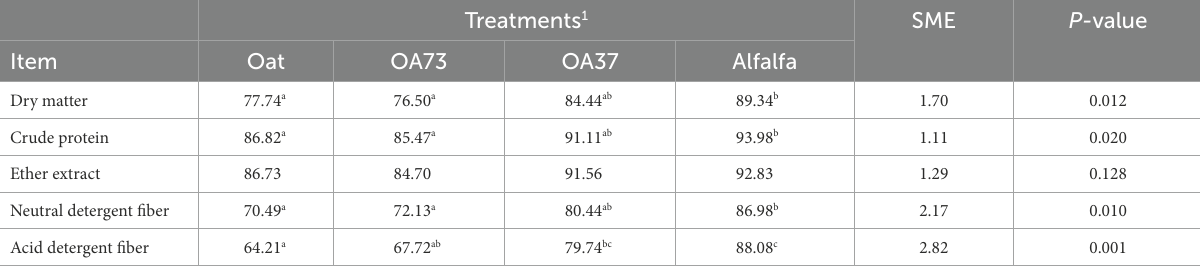
TABLE 3 Effects of oat and alfalfa on apparent digestibility of fattening goats (%).